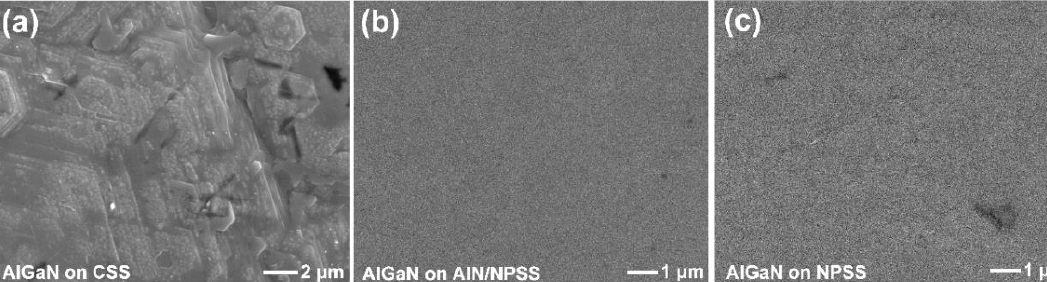
Figure 4. Top-view SEM images of the surface morphologies of the AlGaN epilayers grown on the ( a ) CSS; ( b ) AlN/NPSS; and ( c ) NPSS [17].